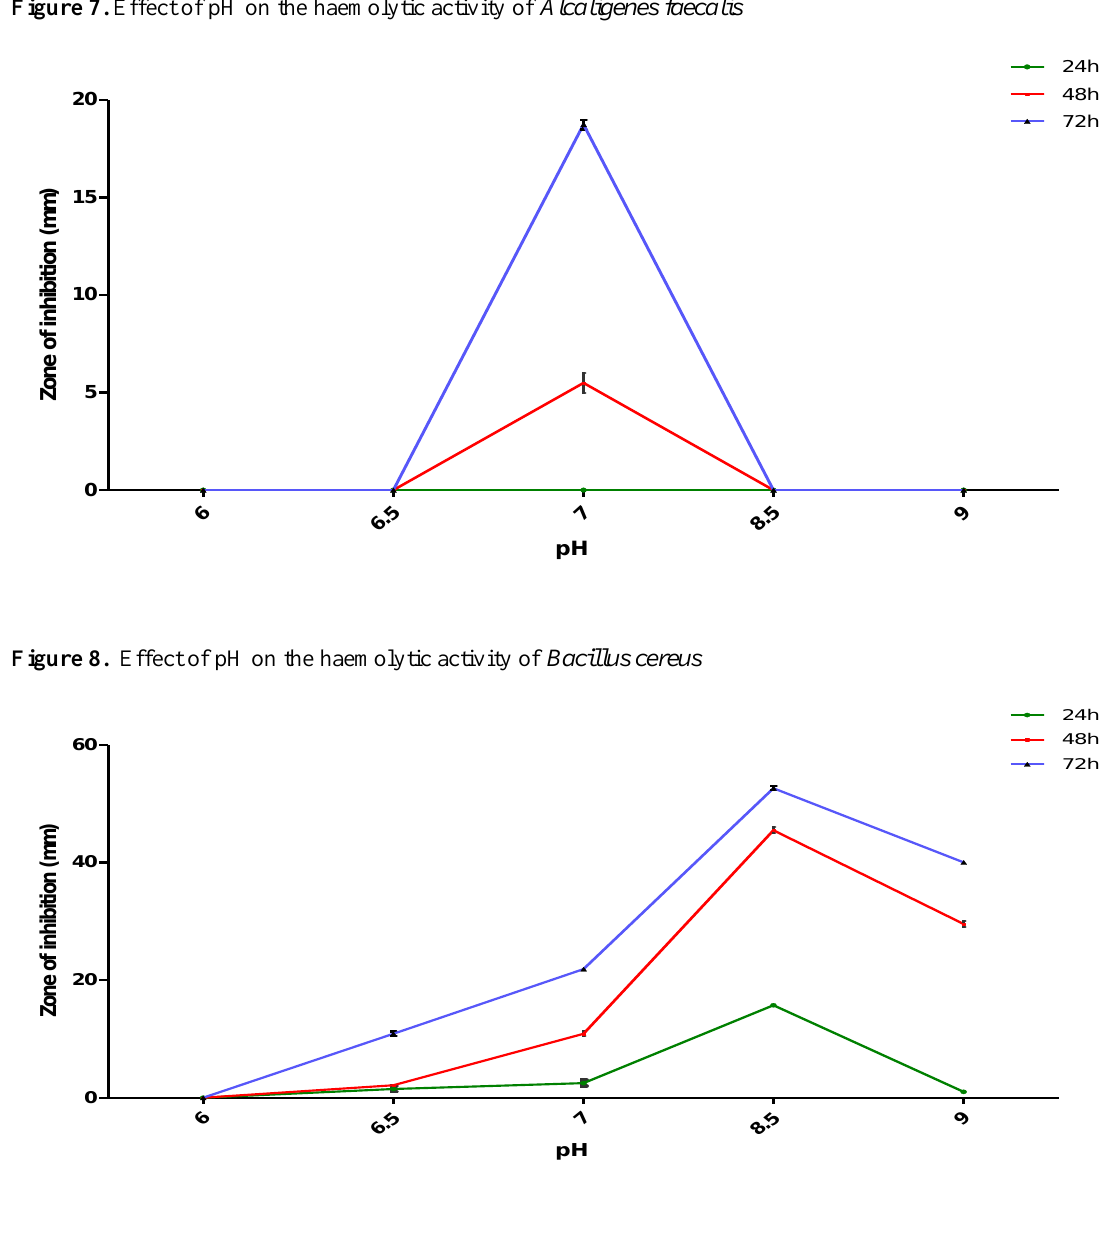
Figure 7. Effect of pH on the haemolytic activity of Alcaligenes faecalis